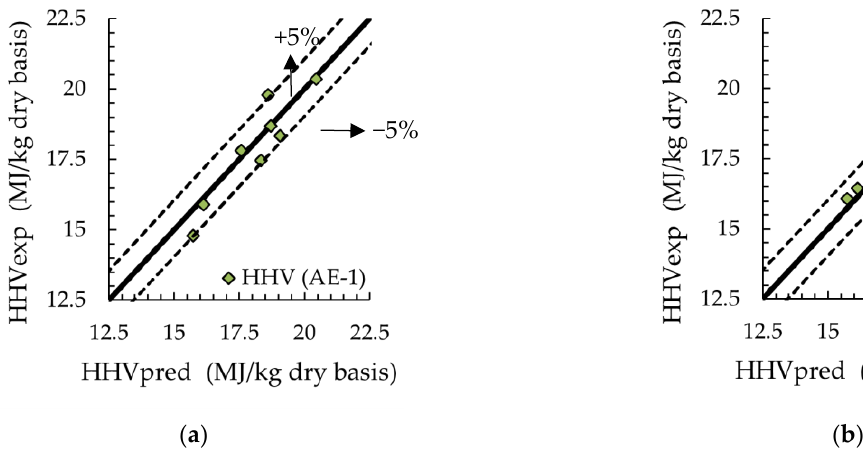
Figure 8. Comparison of the predicted and experimental values for HHVs with the different proposed equations using ultimate analysis parameters: ( a ) AE-1; ( b ) AE-2.